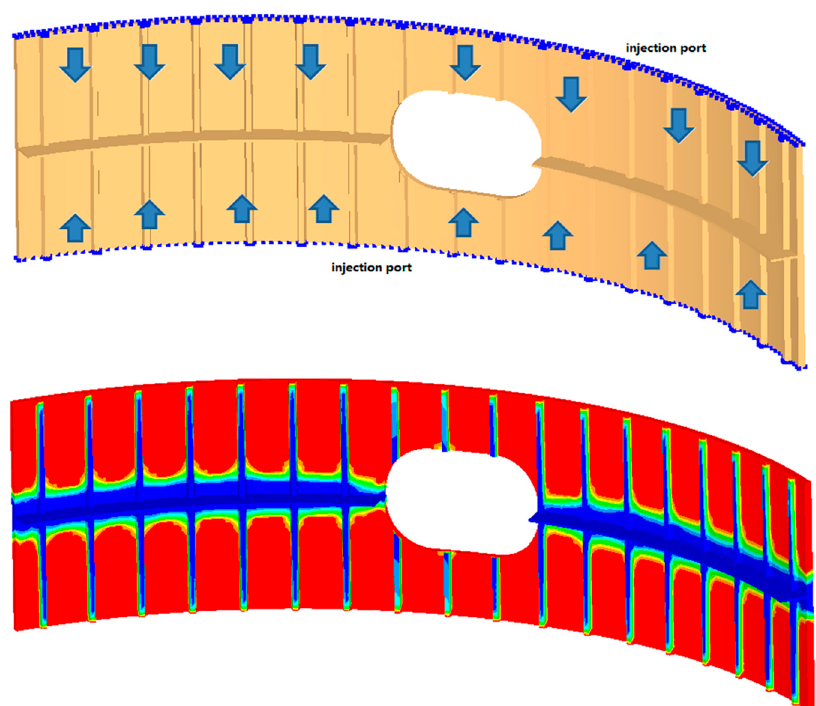
Figure 17. Injection case B for the fuselage section.